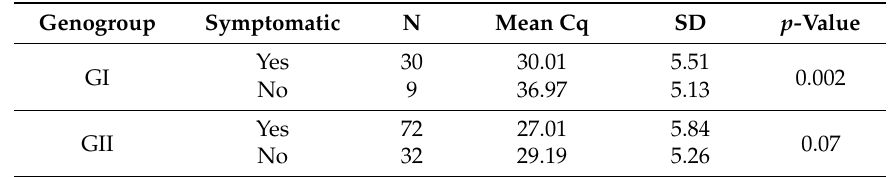
Table 5. Di ff erence in viral load between symptomatic and infected asymptomatic persons according to